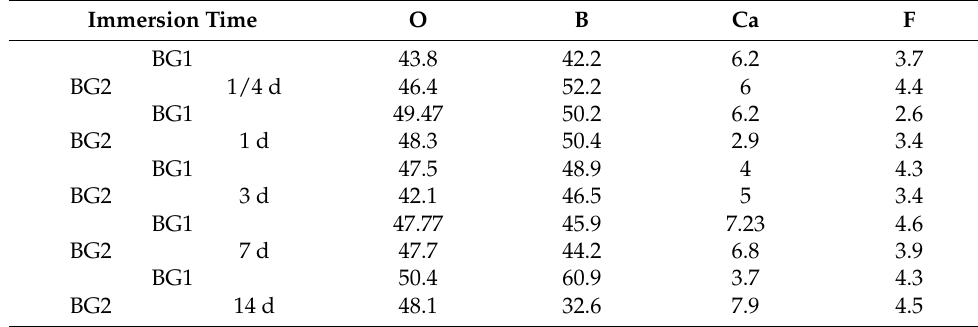
Table 2. Average elemental composition of the two BGs.